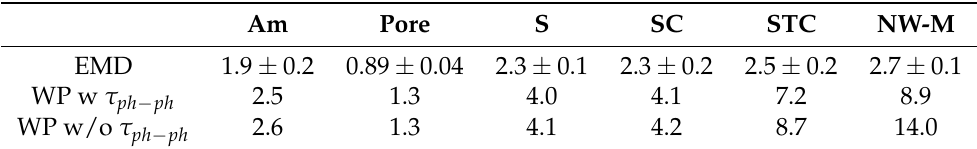
Table 4. Thermal conductivity in Wm − 1 K − 1 at 300 K for the different configurations, computed with EMD or estimated with Equations (3) and (4). Am Pore S SC STC NW-M